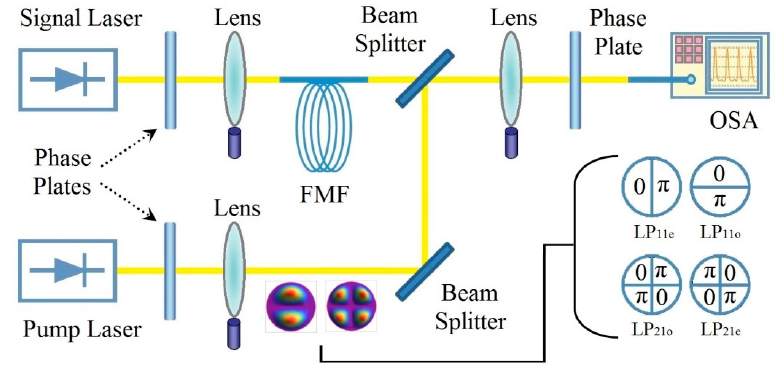
Figure 5. Schematic of the few-mode distributed Raman amplifier.